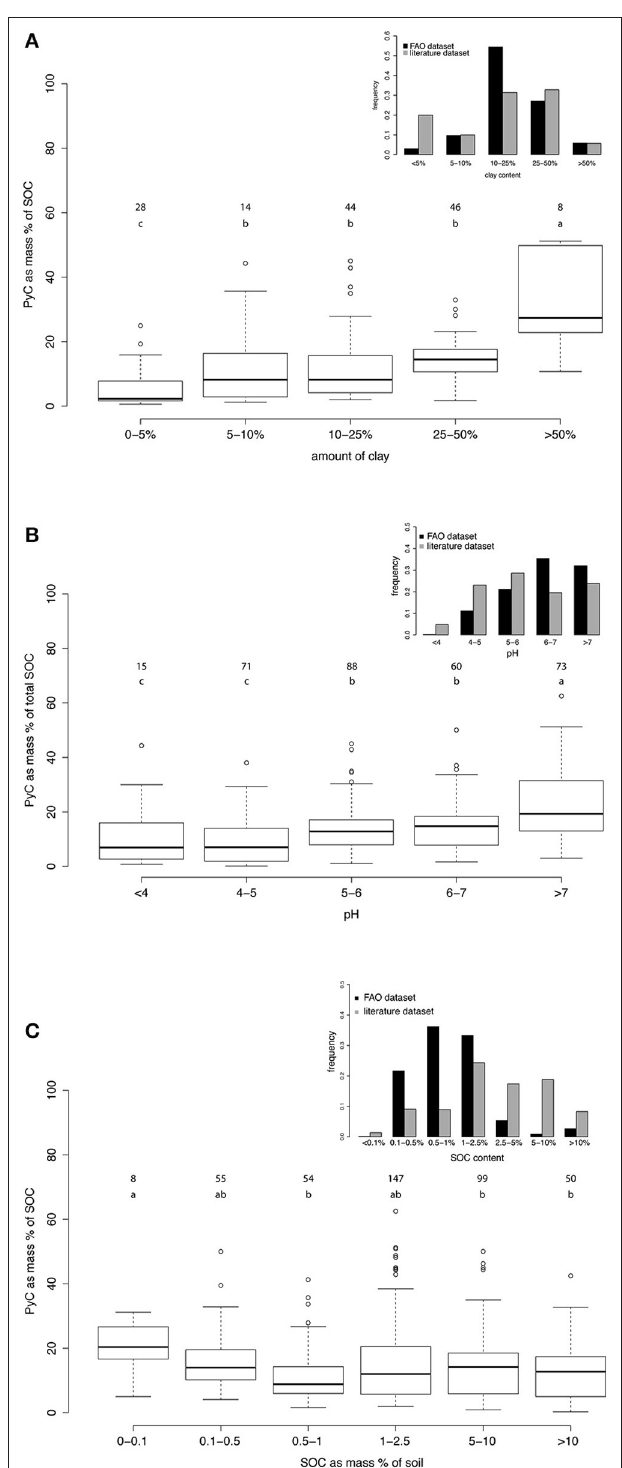
FIGURE 8 | PyC content as mass % of the total SOC described by different soil parameters: The clay content (A); pH (B); total SOC content (C). The One-Way-ANOVA resulted in p < 0.001 for the clay content, < 0.001 for the pH, and < 0.01 for the SOC content. The different letters on the top indicate the significant differences ( p < 0.05) within each